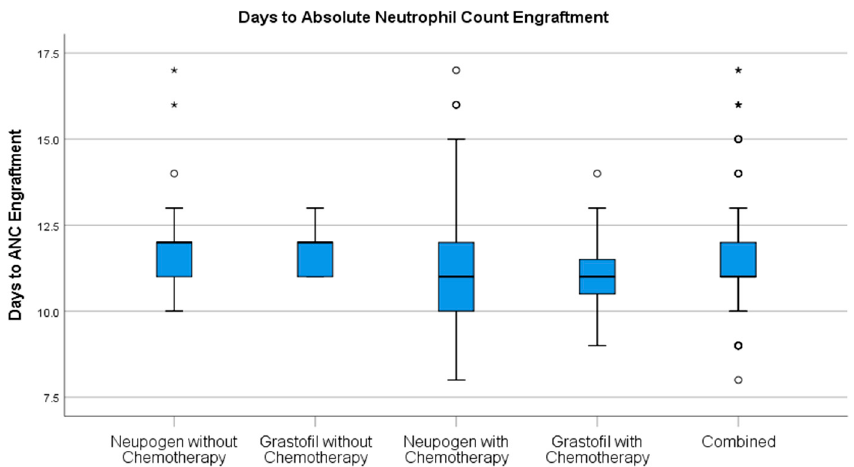
Figure 1. Days to ANC engraftment comparison for patients receiving Neupogen ® or Grastofil ® . * denotes extreme